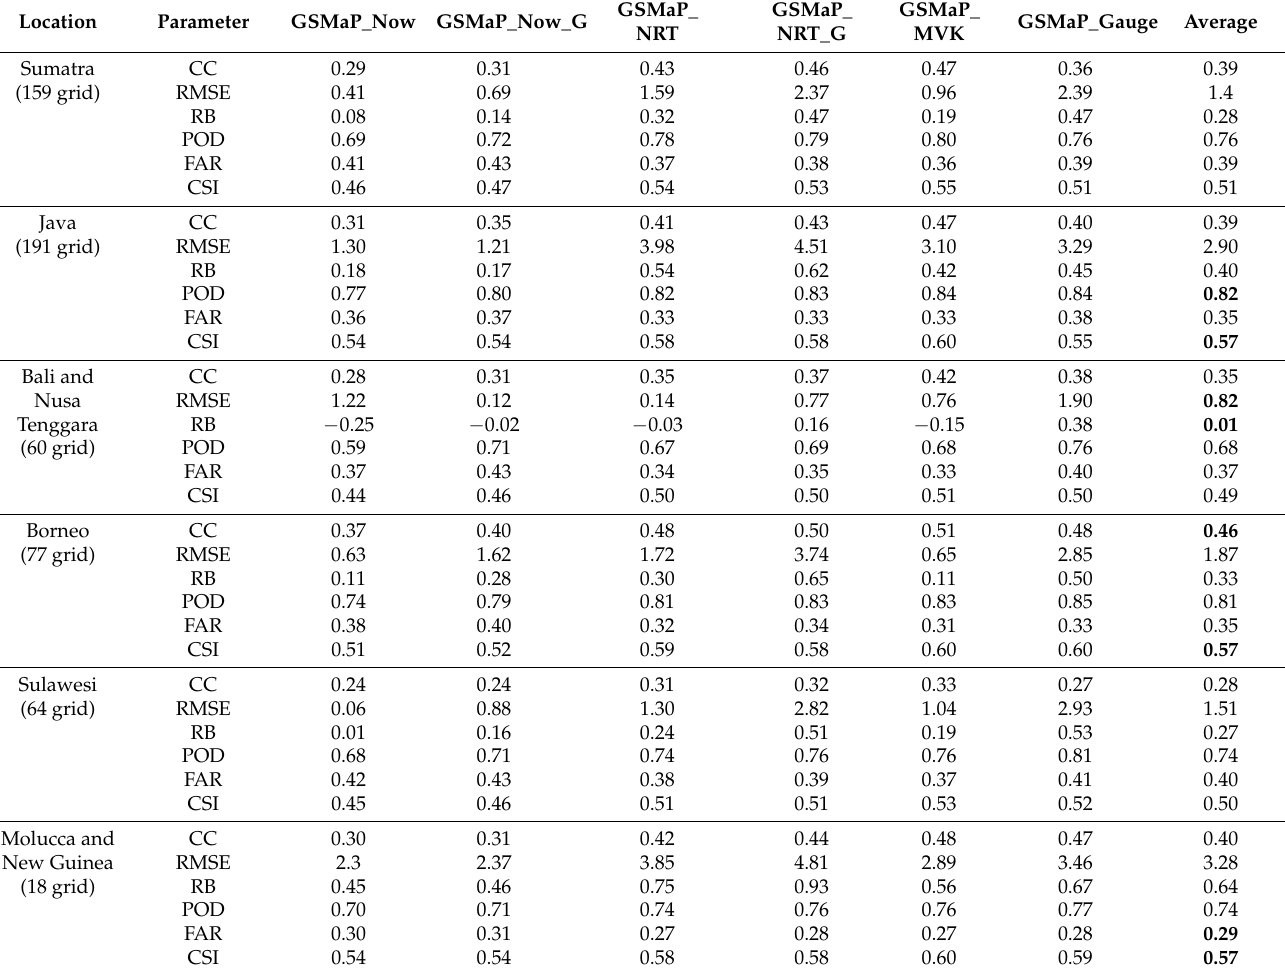
Table 8. Daily data statistical test for several Indonesian